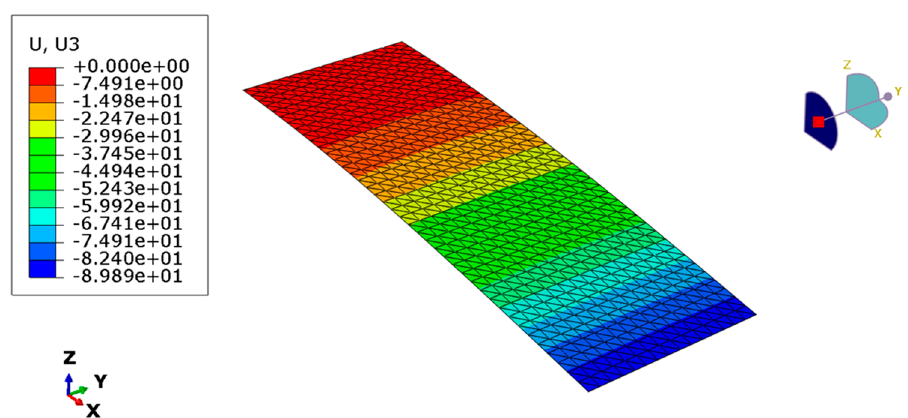
Figure 5. Exemplary deflection result of structural simulation. In this case, the maximum absolute deflection D z is 89.89 mm.